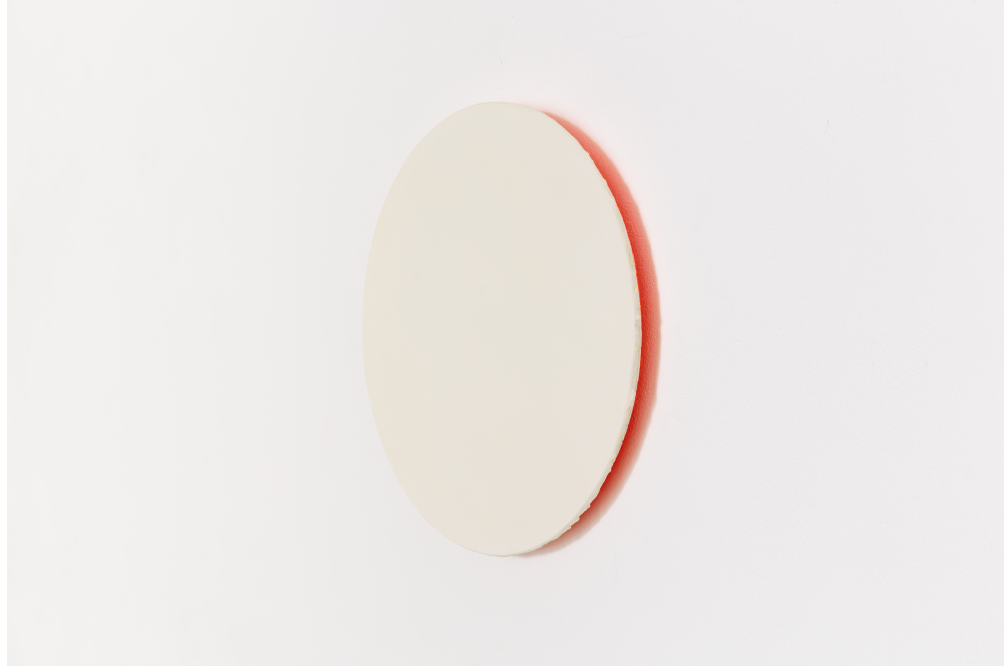
Figure 1: Jo Volley, Time Painting,